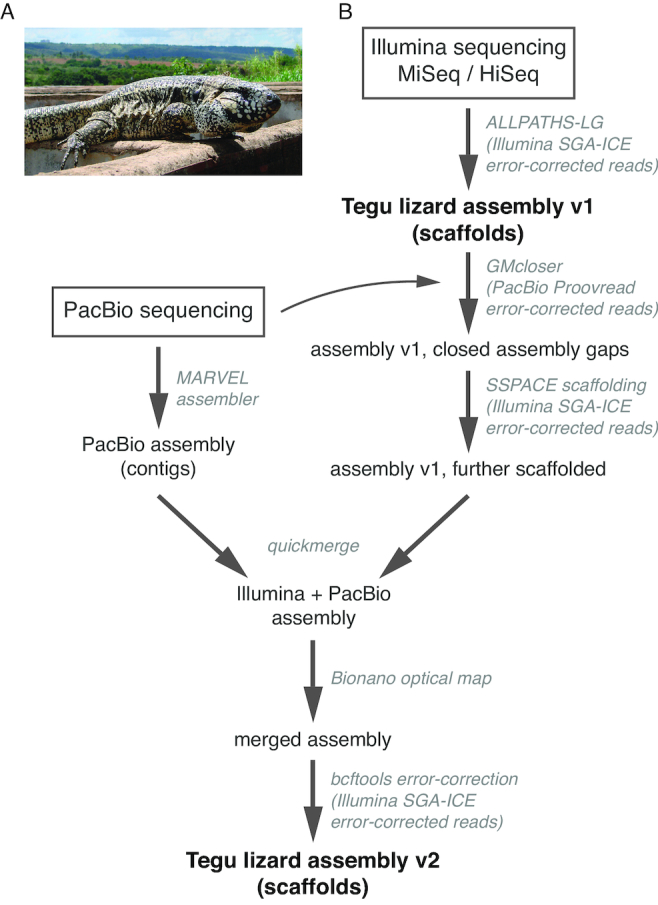
Workflow to generate the tegu lizard v2 assembly. (A) The tegu lizard, Salvator merianae. (B) Assembly v1 was built entirely from Illumina short-read data. To improve this assembly, we used Pacific Biosciences (PacBio) long-read data to close assembly gaps and extend scaffolds and merged the improved Illumina with a PacBio-only assembly. Finally, optical mapping data were used to resolve contig chimeras and scaffold even further. Used tools and their input data are shown in gray.